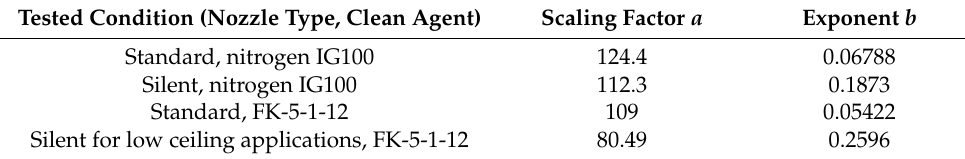
Table 4. Constant scaling factor and exponent for the fitting curves generated through a power law